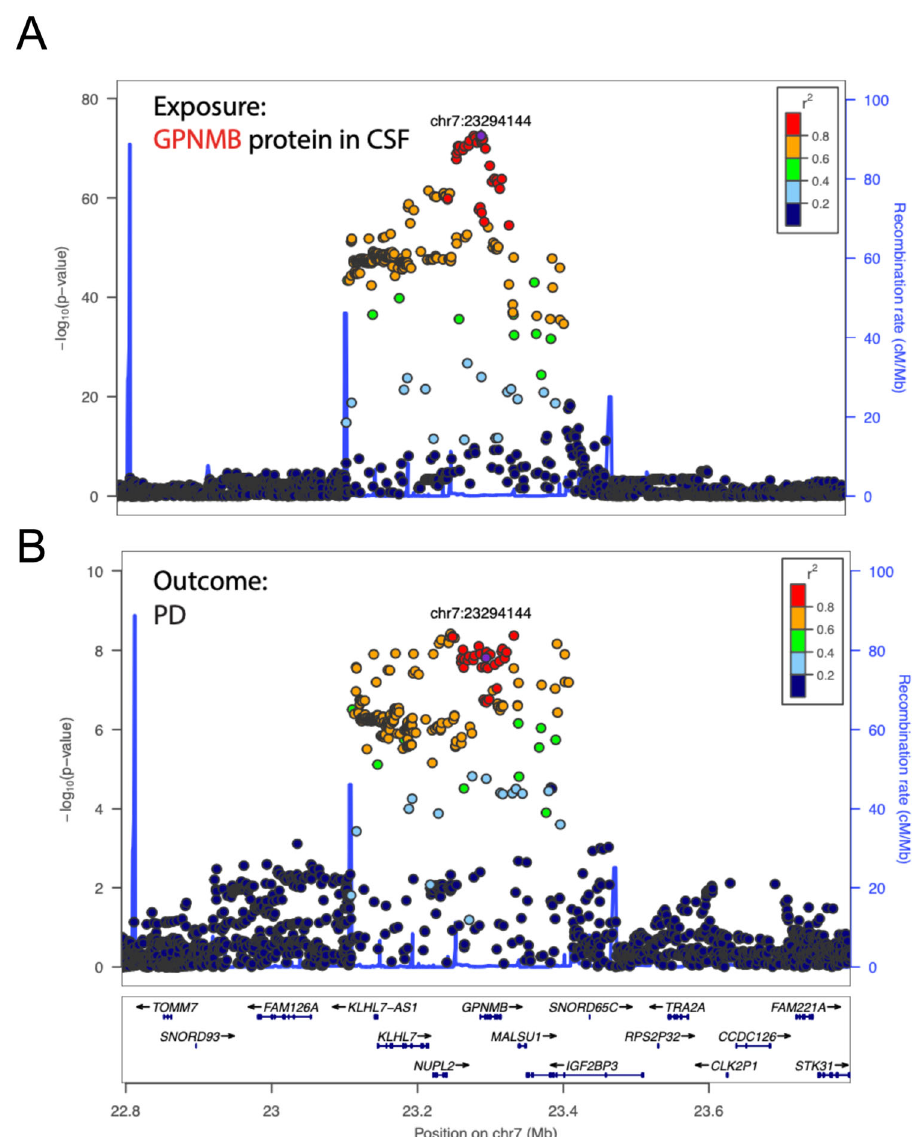
Fig. 2 Causal Analysis. A Locus visualization of GPNMB pQTL hits suggest a strong association between GPNMB SOMAmer levels and its cis- SNPs. Colors indicate the linkage disequilibrium (LD) correlation of other SNPs with chr7:23294144 (rs858275). B Locus visualization of GWAS hits in the GPNMB locus for the risk of developing PD. The y- axis is the − log10 nominal p value of the GWAS 889 and 600 SOMAmers, respectively. Applying consensus clustering on these two protein modules split the idiopathic subcohort (350 patients) in proteome-based patient endotypes 1 (185 patients) and 2 (165 patients) (Fig. 3A). As seen in the tracking plot (Fig. 3B) these endotypes suffer only negligible changes as the number of modeled subclasses increases. Moreover, a predictive model for the endotypes was built based on clinical parameters, avoiding the re-use of the same proteomic data involved in the de fi nition of the endotypes. Patients with CSF phospho-tau ≥ 11 pg/mL (as measured with the Elecsys ® assay) were enriched for endotype 1, and patients with CSF phospho-tau <11 pg/mL were enriched for endotype 2 (Fig. 3C). The model accuracy in the training (244 patients) and in the independent test (106 patients) sets, was 0.82 and 0.73, respectively. The estimated area under the curve for the test set was 0.77. Endotypes did not signi fi cantly differ in age or sex. There were neither signi fi cant differences in caudate, striatum or putamen thickness, nor in UPDRS score parts II and III or MoCA scores.